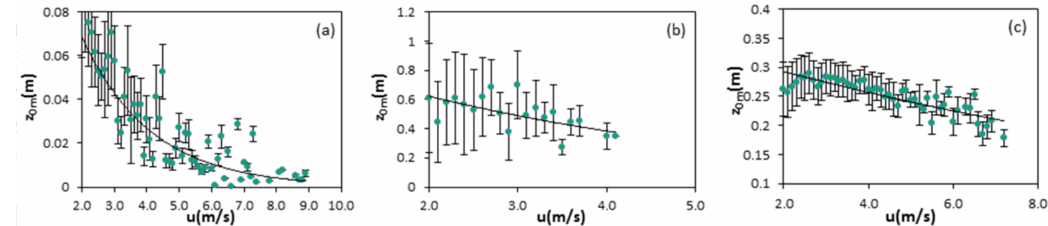
Figure 3. Distribution of half-hourly z 0m under variant wind speed scope at ( a ) Arou station; ( b ) Guantan station and ( c ) Daman station. Error bars centred at each data point indicate 95% confidence intervals of the regression estimate; an exponential trend line is added for each data